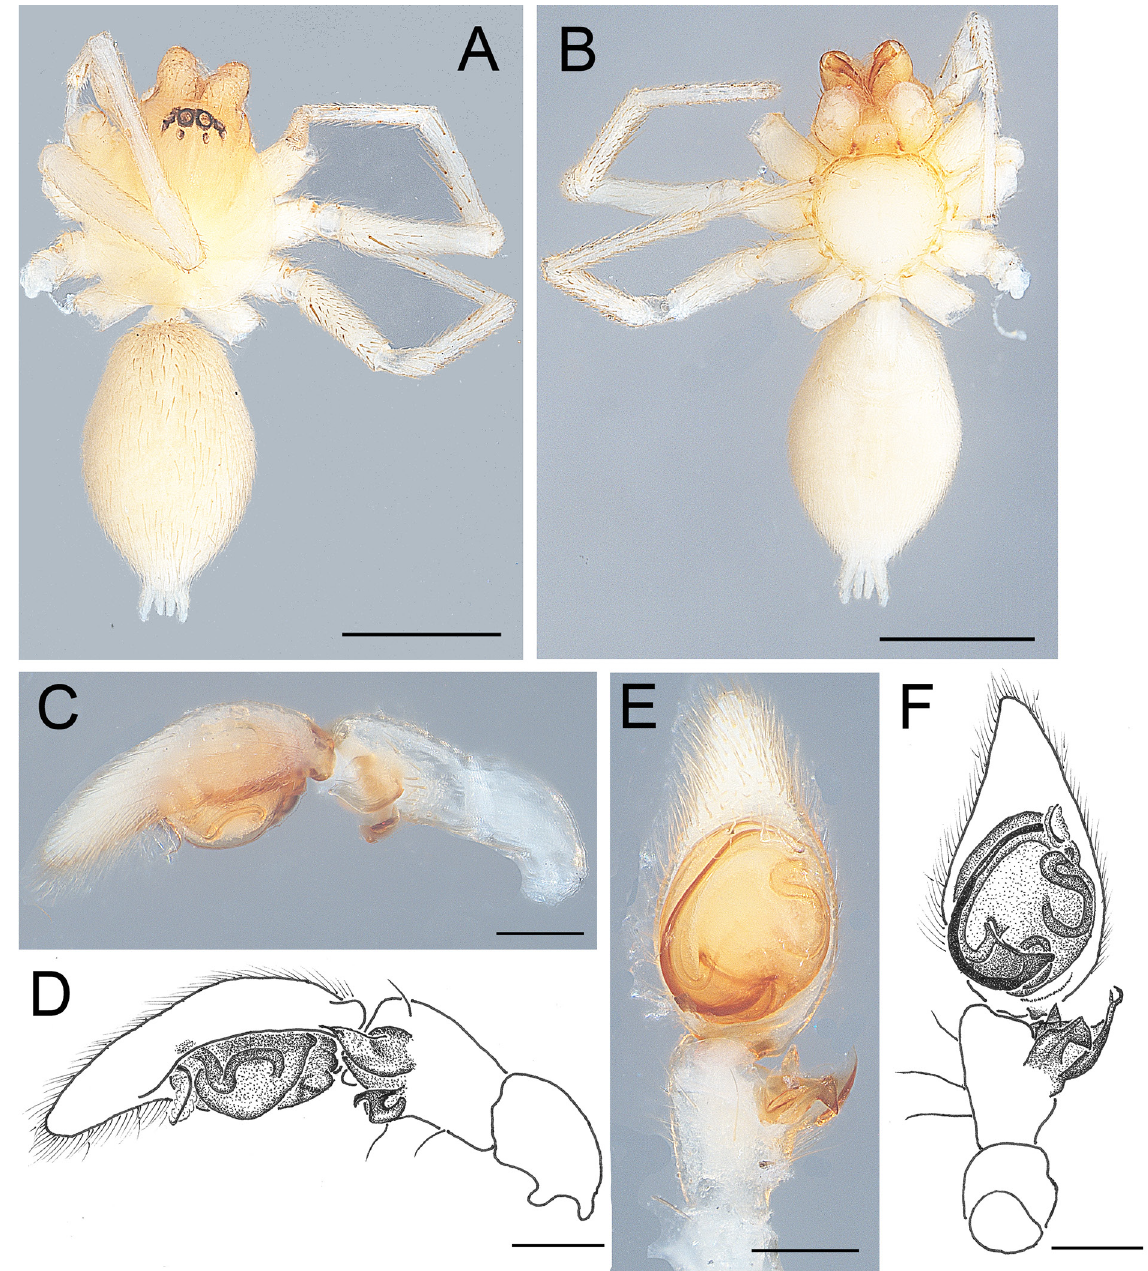
Fig. 28. Andromma juakalyi sp. nov., ♂, holotype (BE_RMCA_ARA.Ara 247539). A . Habitus, dorsal view. B . Same, ventral view. C–D . ♂, left palp, retrolateral view. E–F . Same, ventral view. Scale bars: A–B = 1 mm; C–F = 0.2